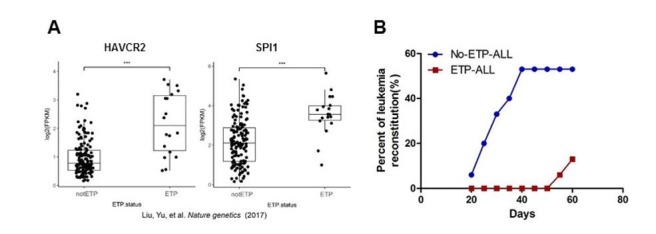
ETP and non-ETP T-ALL have different HAVCR2 and SPI1 expression levels and leukemia reconstitution abilities.(A). The HAVCR2 and SPI1 expression levels are significant higher in ETP T-ALL samples as compared to non-ETP T-ALL samples. ***, p<0.001. (B). Bone marrow cells (1X106) from human T-ALL patients were i.v. injected into the NSG mice. Leukemia reconstitution was determined when >25% of the cells in the peripheral blood were human CD45+;CD7+ leukemic cells.